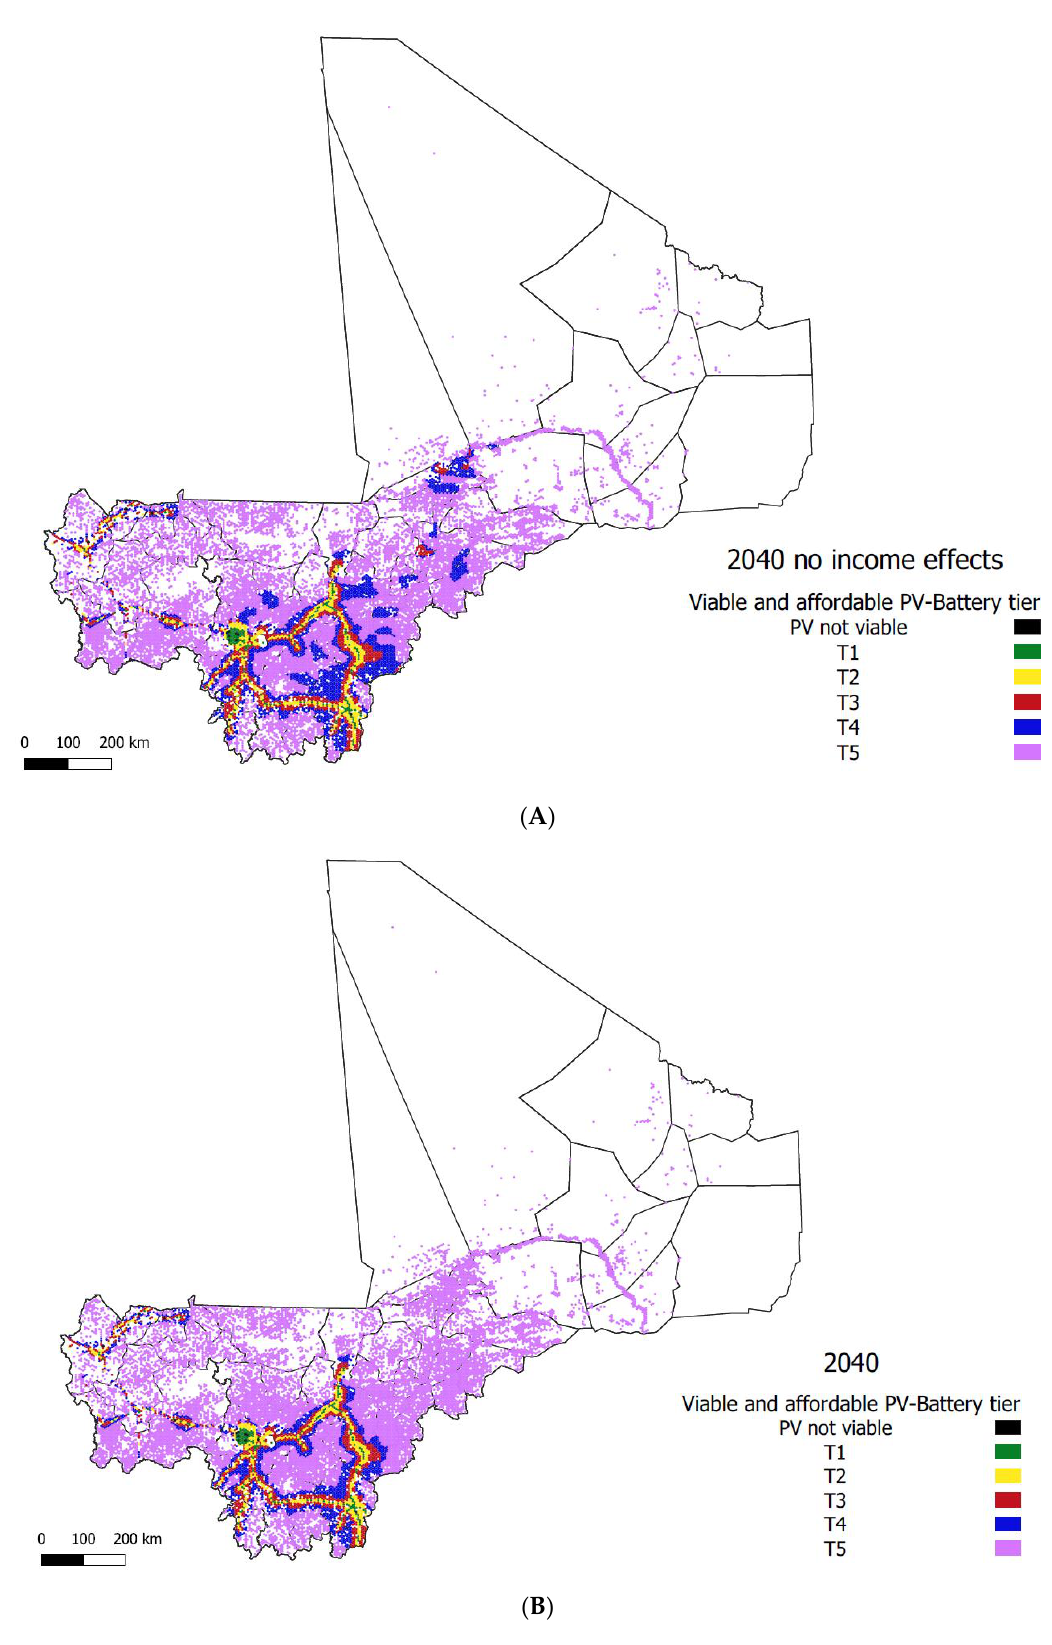
Figure 9. Viable and affordable electrification tier of the geographical units for the assumptions valid for 2040. ( A ) Without the influence of electricity consumption on income. ( B ) Influences of electricity consumption on income are considered.